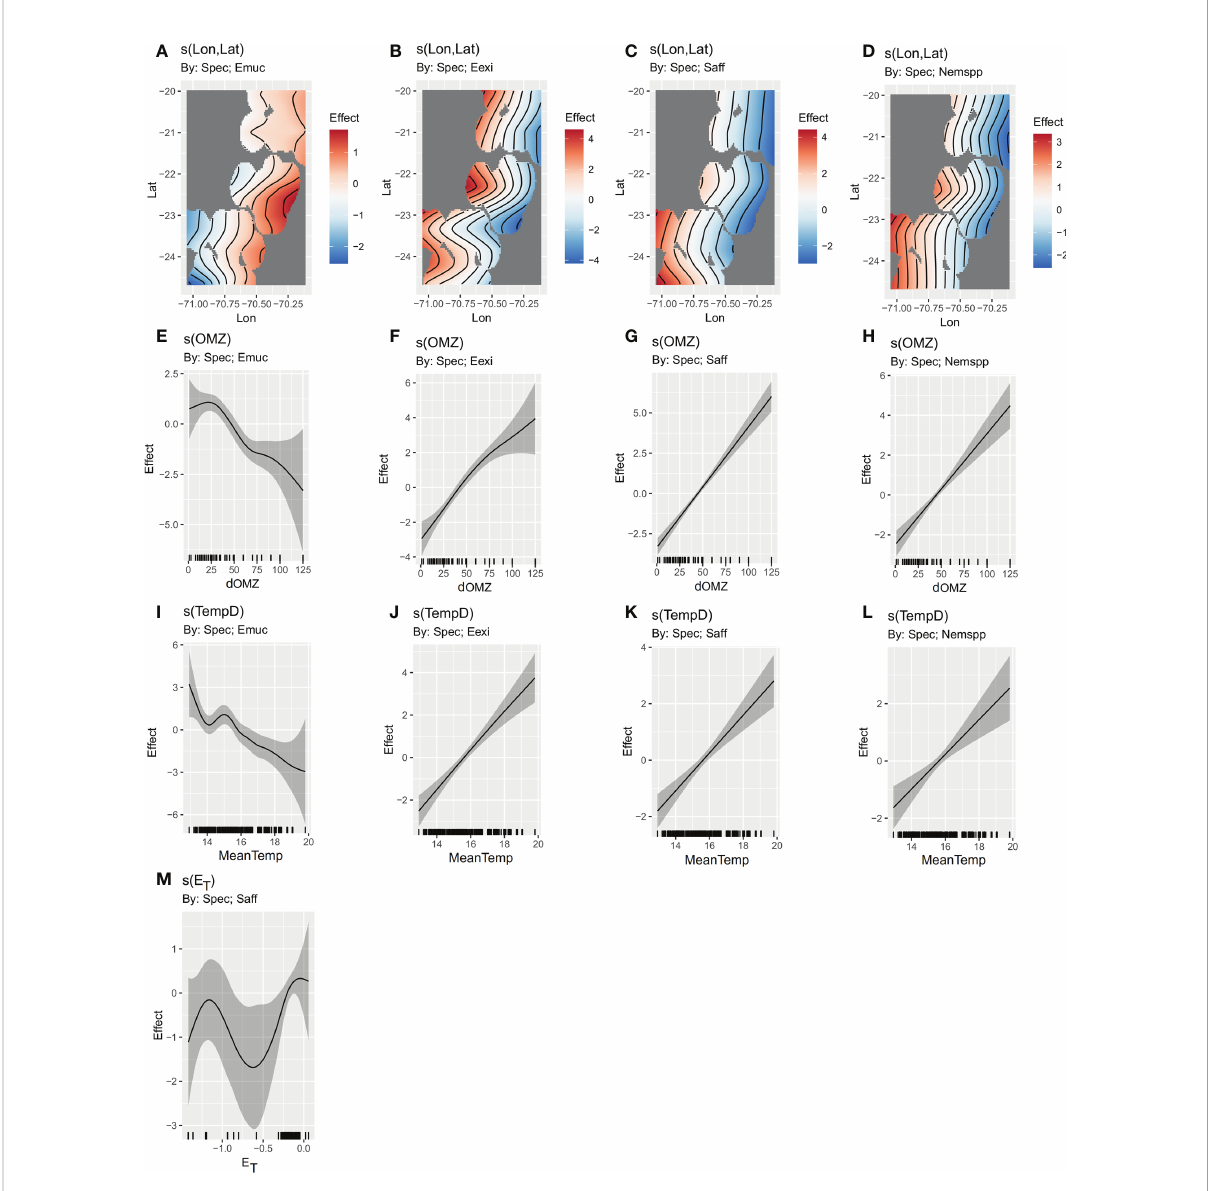
FIGURE 7 HGAM models, showing function smooths with 95% con fi dence bands of the selected covariates, in different models. (A – D) Spatial model, (E – H) dOMZ model, (I – L) MeanTemp model, and (M) effect of E T from fi nal model. Only signi fi cant terms are shown. Emuc, E. mucronata , Eexi, E. eximia , Saff, S. af fi ne , and Nemspp, Nematoscellis